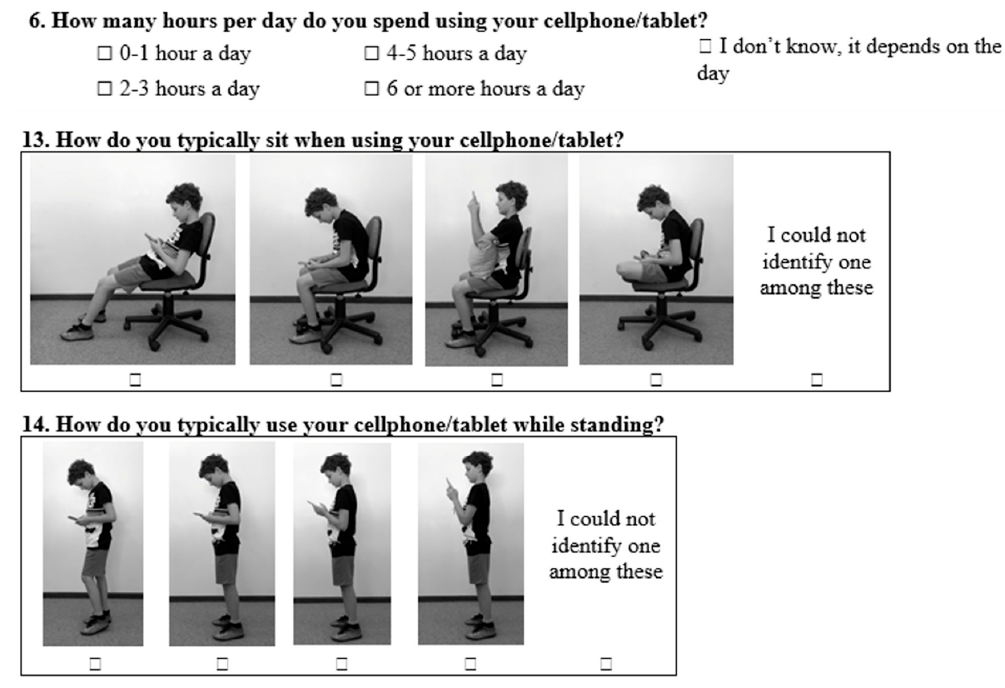
Figure 1. New questions (6, 13–14) assessing the use of mobile devices included in of the BackPEI- CA questionnaire.